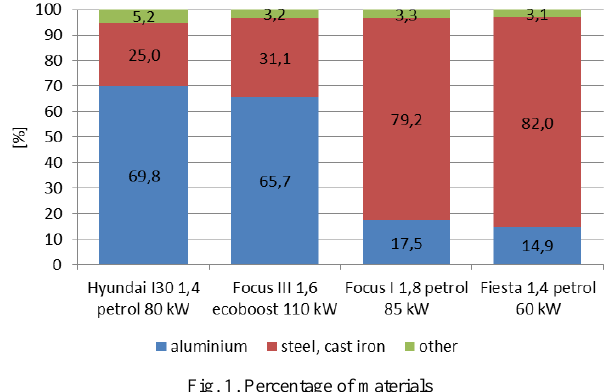
Fig. 1. Percentage of materials